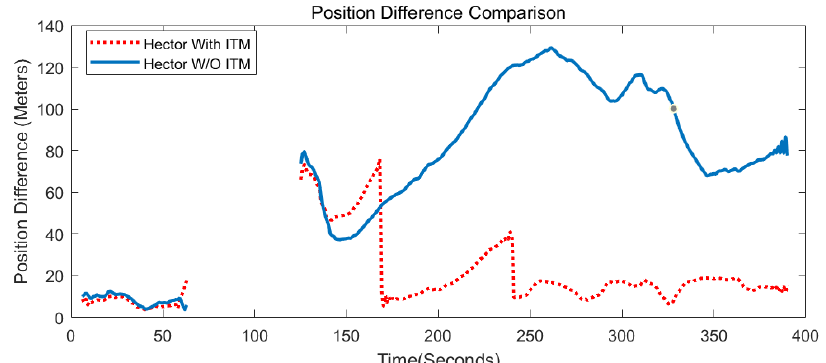
Figure 10. Position difference comparison of Hector SLAM with and without